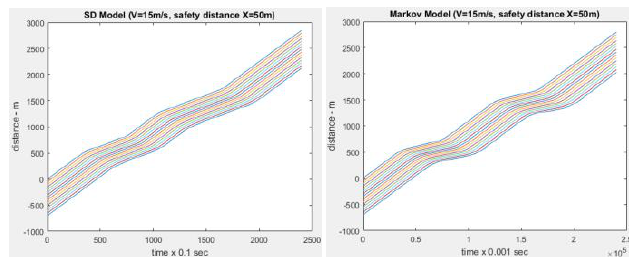
Fig. 15. The impact of Markov model parameters on the relative velocities.